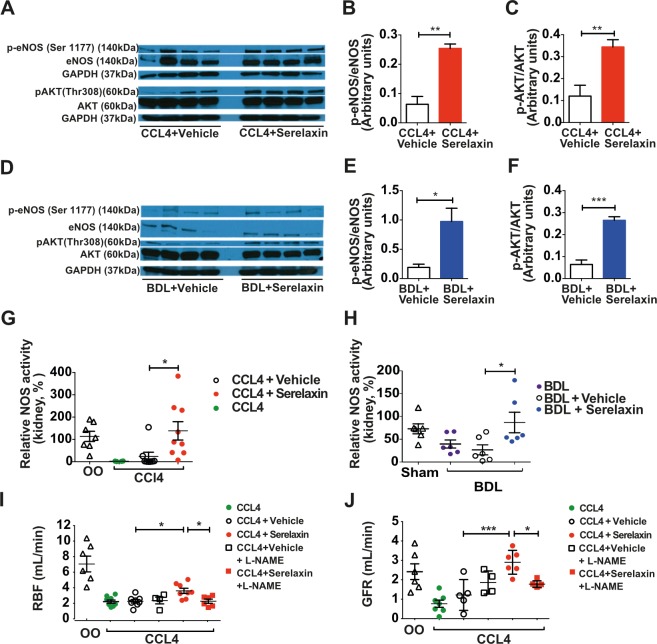
Effect of sustained serelaxin infusion on AKT/eNOS/NO signaling in cirrhotic rat kidney.Quantification of p-eNOS/eNOS and p-AKT/AKT in whole kidney extracts from 72-h serelaxin- or vehicle-treated 16-wk CCl4 and 4-wk bile duct ligation (BDL) rats (n = 4) (A–F). Data presented as mean ± standard error of the mean (SEM), analyzed by unpaired t-test (*p < 0.05; **p < 0.01; ***p < 0.001). NOS activity in whole kidney extracts from CCl4 (G) and BDL (H) rats treated with serelaxin or vehicle (n = 6–8). Data presented as mean ± SEM, analyzed by unpaired t-test (*p < 0.05; **p < 0.01). Renal blood flow (RBF; I) and glomerular filtration rate (GFR; J) in 16-wk CCl4 rats co-treated with L-NG-nitroarginine methyl ester (L-NAME) (n = 4–8). Data presented as mean ± SEM, analyzed by one-way ANOVA with post hoc Bonferroni correction (*p < 0.05; **p < 0.01; ***p < 0.001). OO, olive oil.